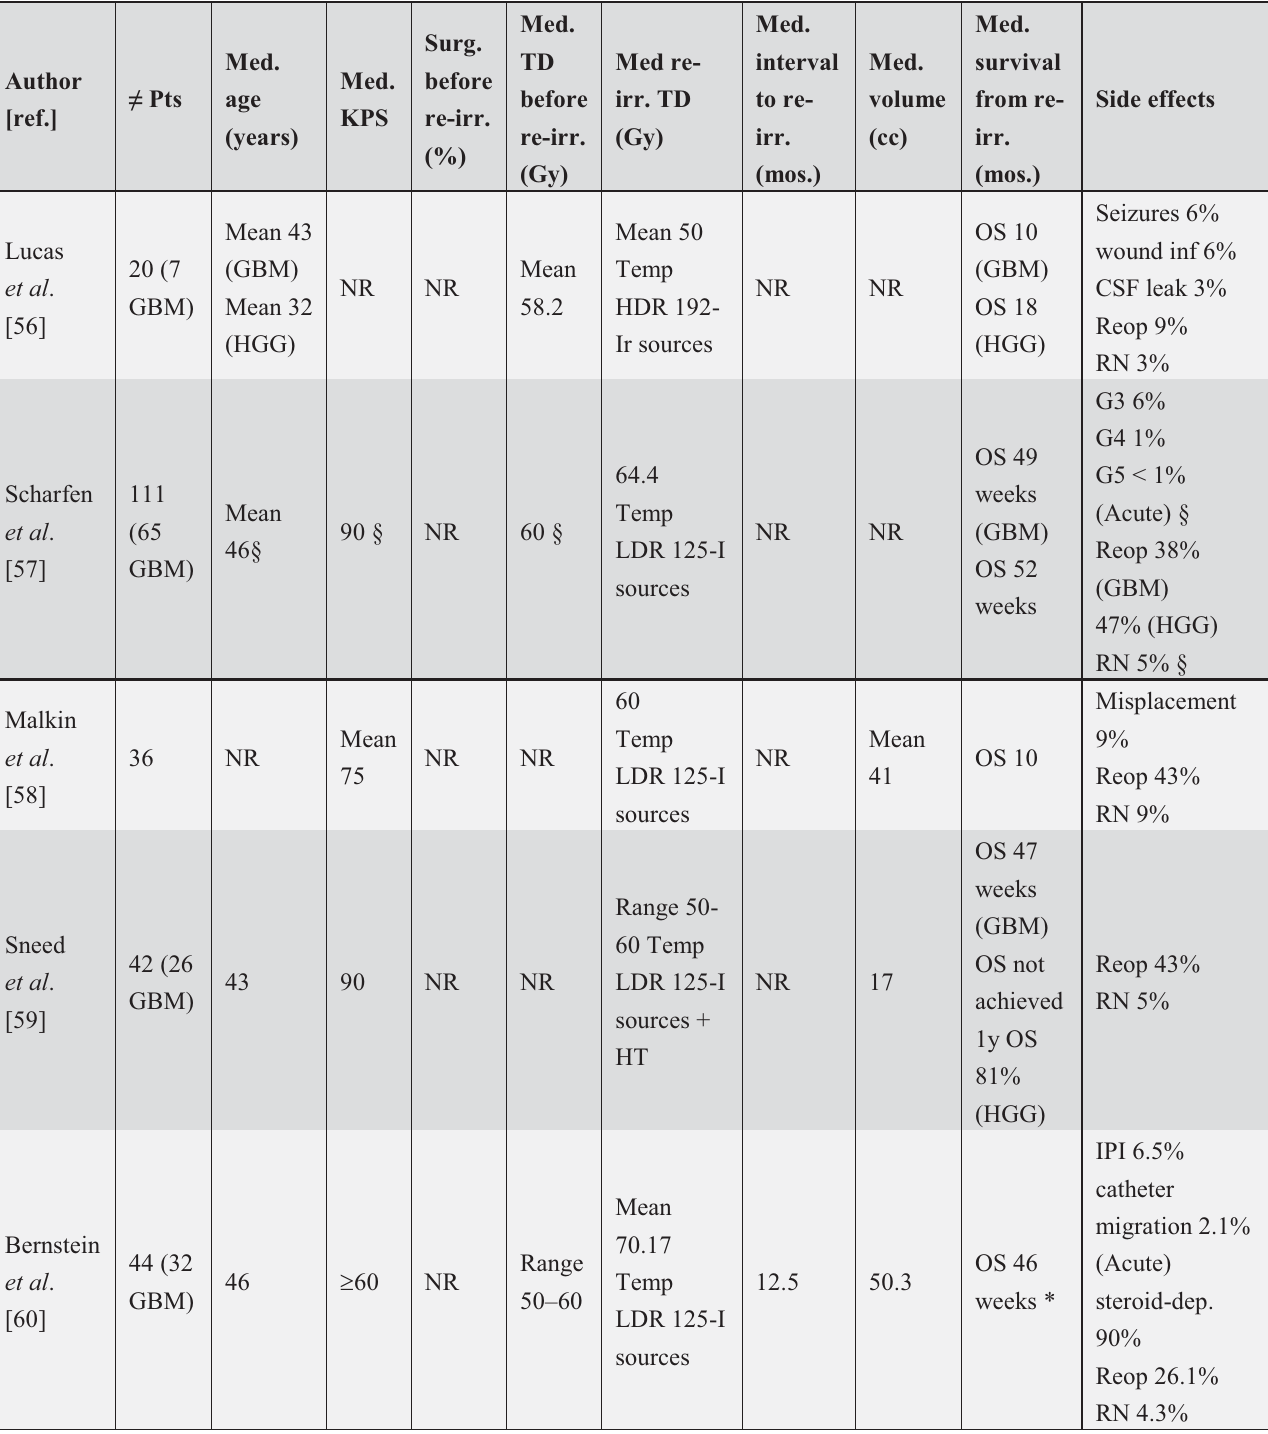
Table 4. Series of high-grade gliomas treated by